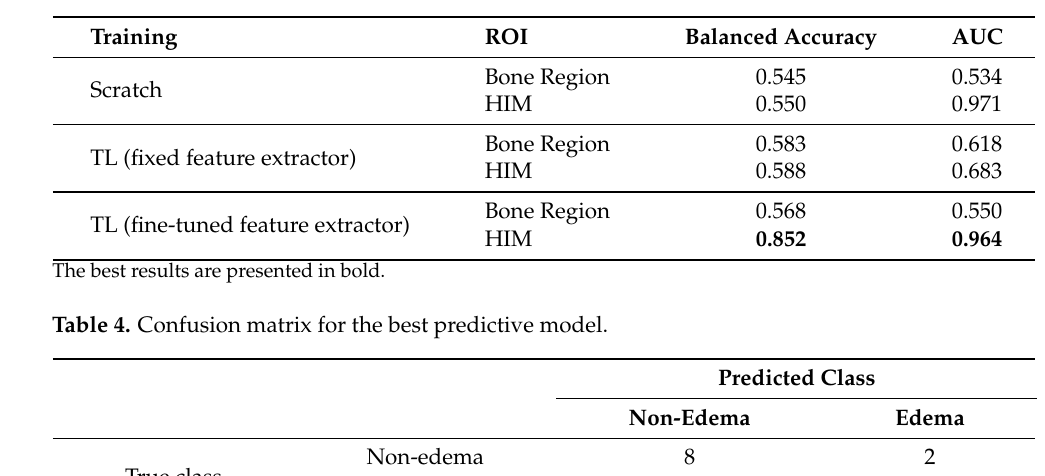
Table 3. Results of the test set using different training strategies and two regions of analysis. Training ROI Balanced Accuracy AUC Bone Region Scratch